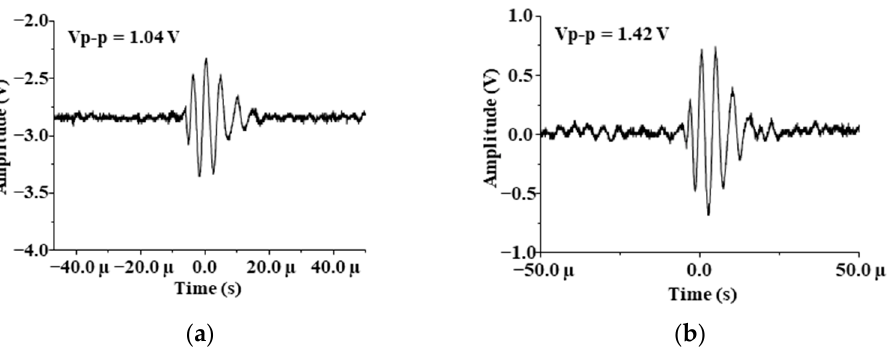
Figure 6. Echo images drawn by computer: ( a ) For water in 1.7 MHz; ( b ) For air in 1.7 MHz.